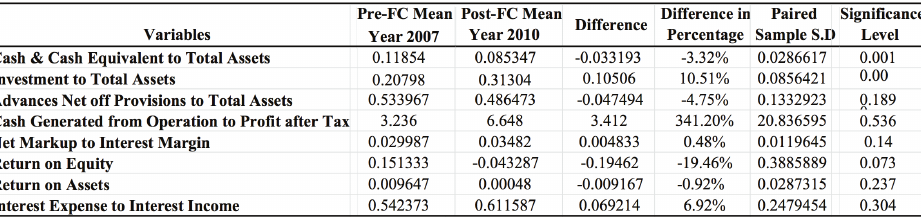
Paired Sample T-test of Different Ratios for the Year 2007 and